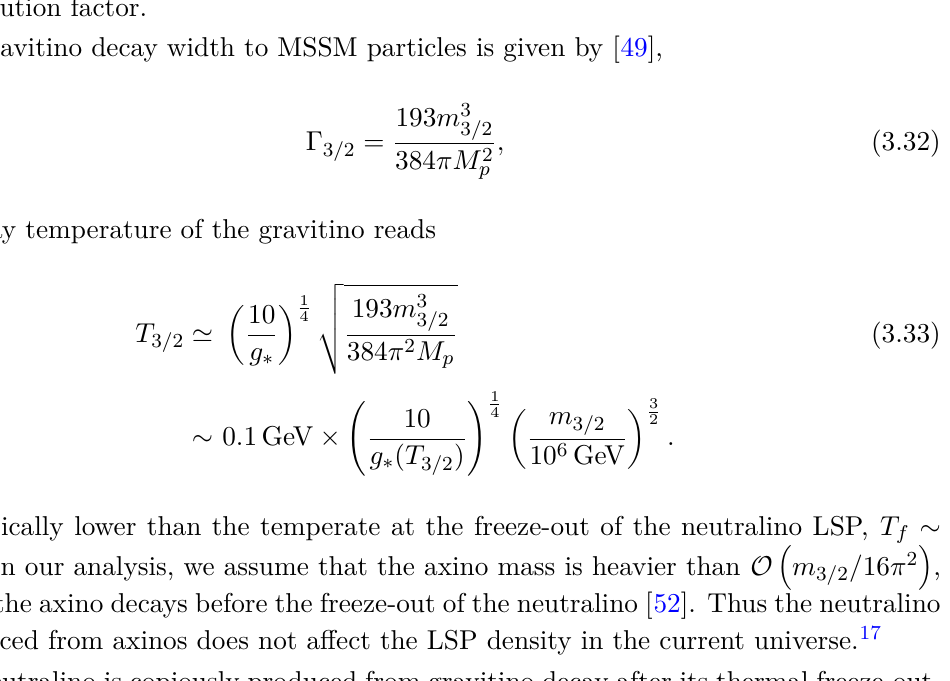
after dilution in the n = 10 , m Figure 7 . Y 3 / 2 the left (right)